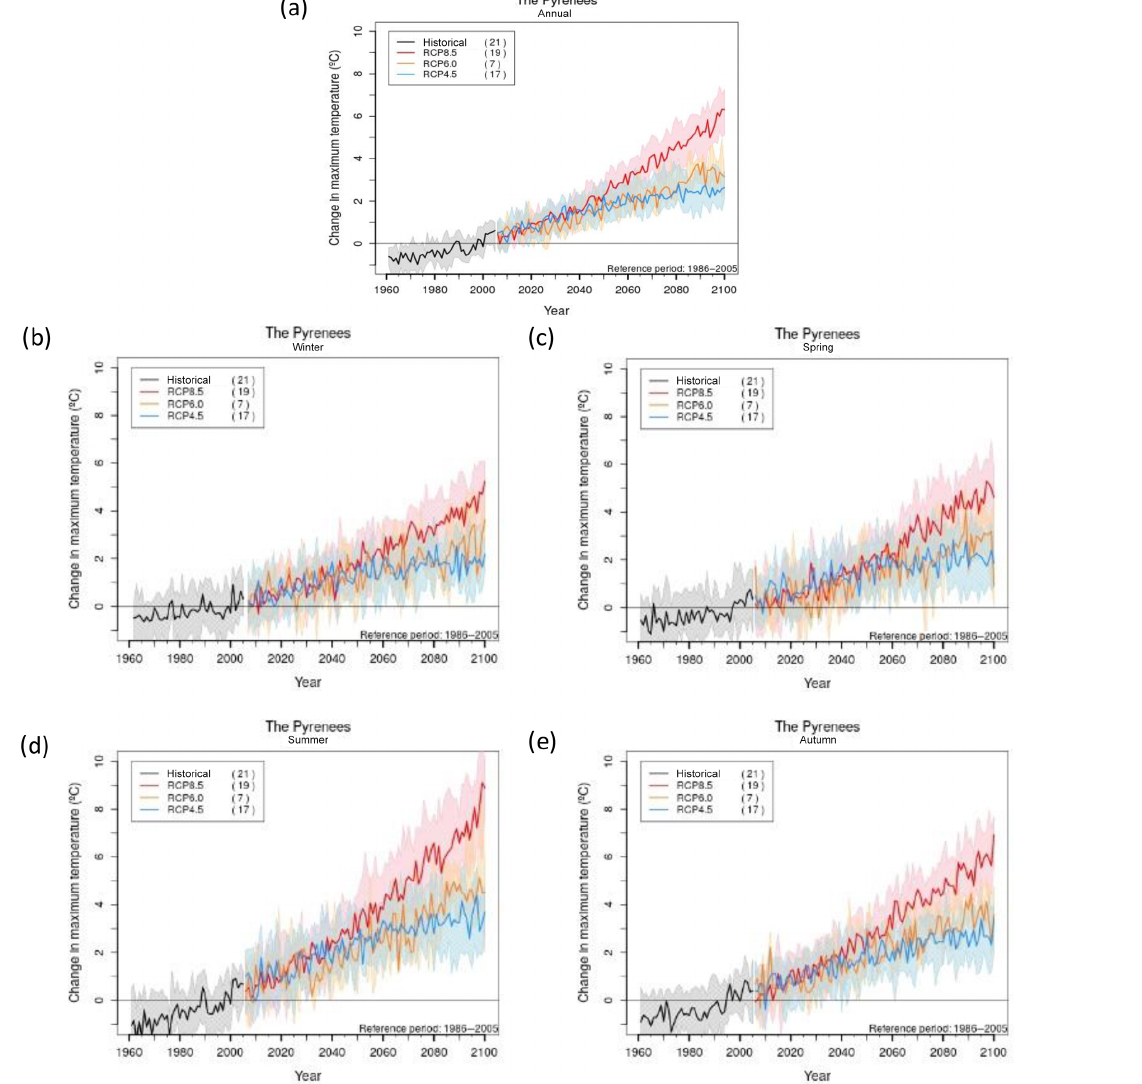
Figure 3. Evolution of downscaled maximum temperature change for the Pyrenees corresponding to: (a) annual average, (b) winter, (c) spring, and (d) summer and (e) autumn. Median is represented by thick line and shadow represents 17th and 83rd percentiles. Num- ber in parentheses indicates the number of models used for the corresponding emission scenario.